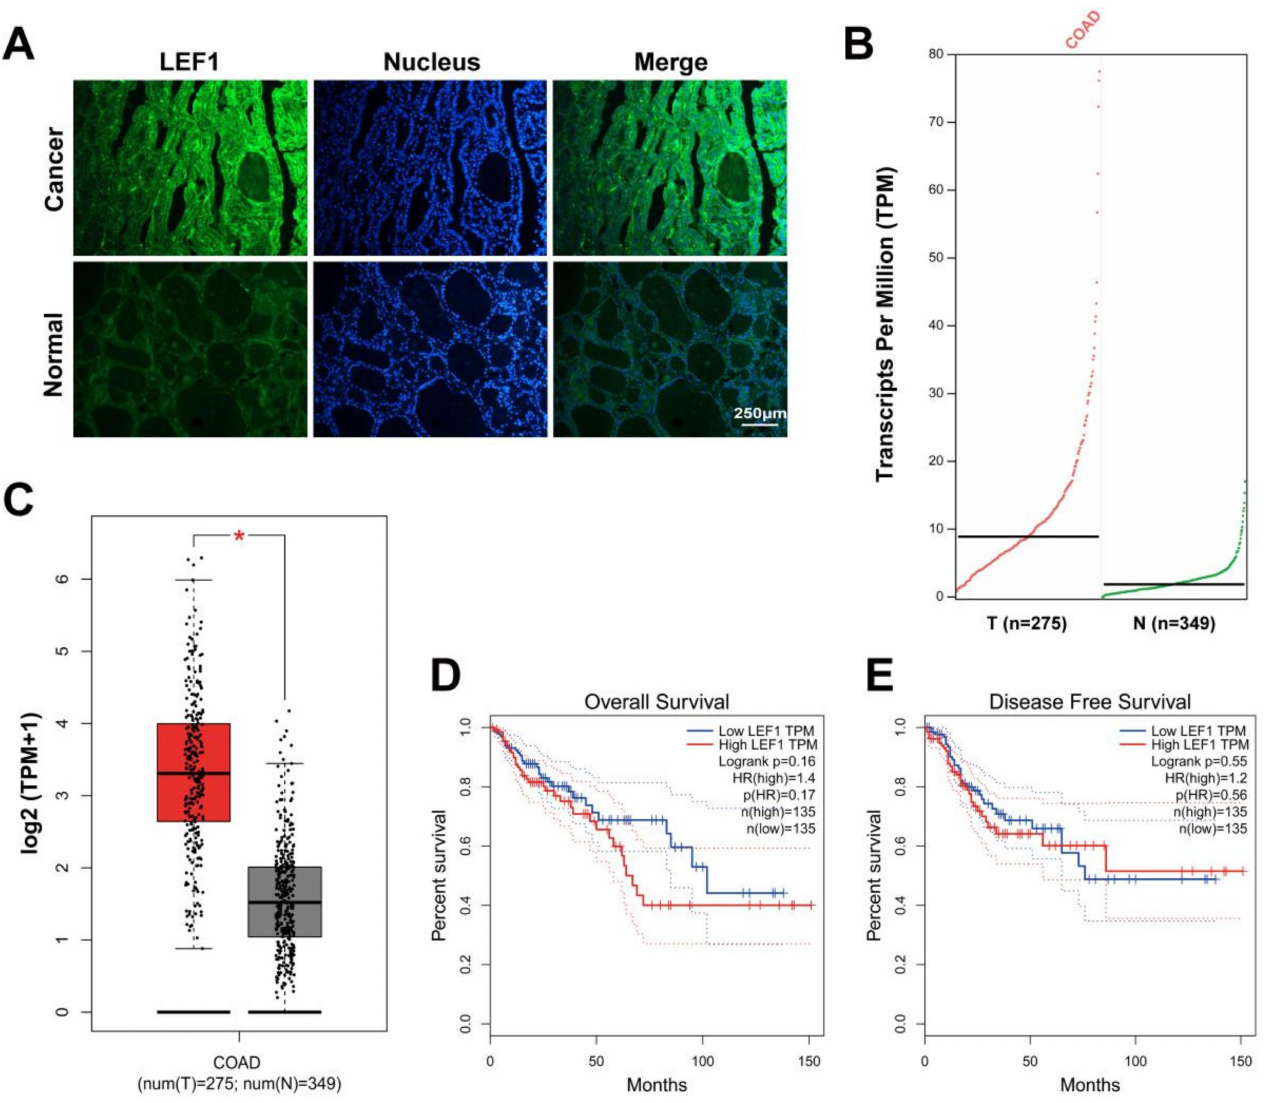
Figure 1. LEF1 was overexpressed in colonic adenocarcinoma tissues and reinforced the progression of colonic adenocarci- noma. ( A ): The expression level of LEF1 in colonic adenocarcinoma tissues was analyzed by IF staining (scale bar = 250 µ m). ( B , C ): The LEF1 mRNA expression level in tumor tissues and paired normal tissues (* p < 0.05). ( D , E ): Kaplan-Meier curves showing the 10-year overall survival rate and disease free survival rate in patients with high LEF1 expression ( n = 135) and low LEF1 expression ( n = 135). The data were analyzed by one-way